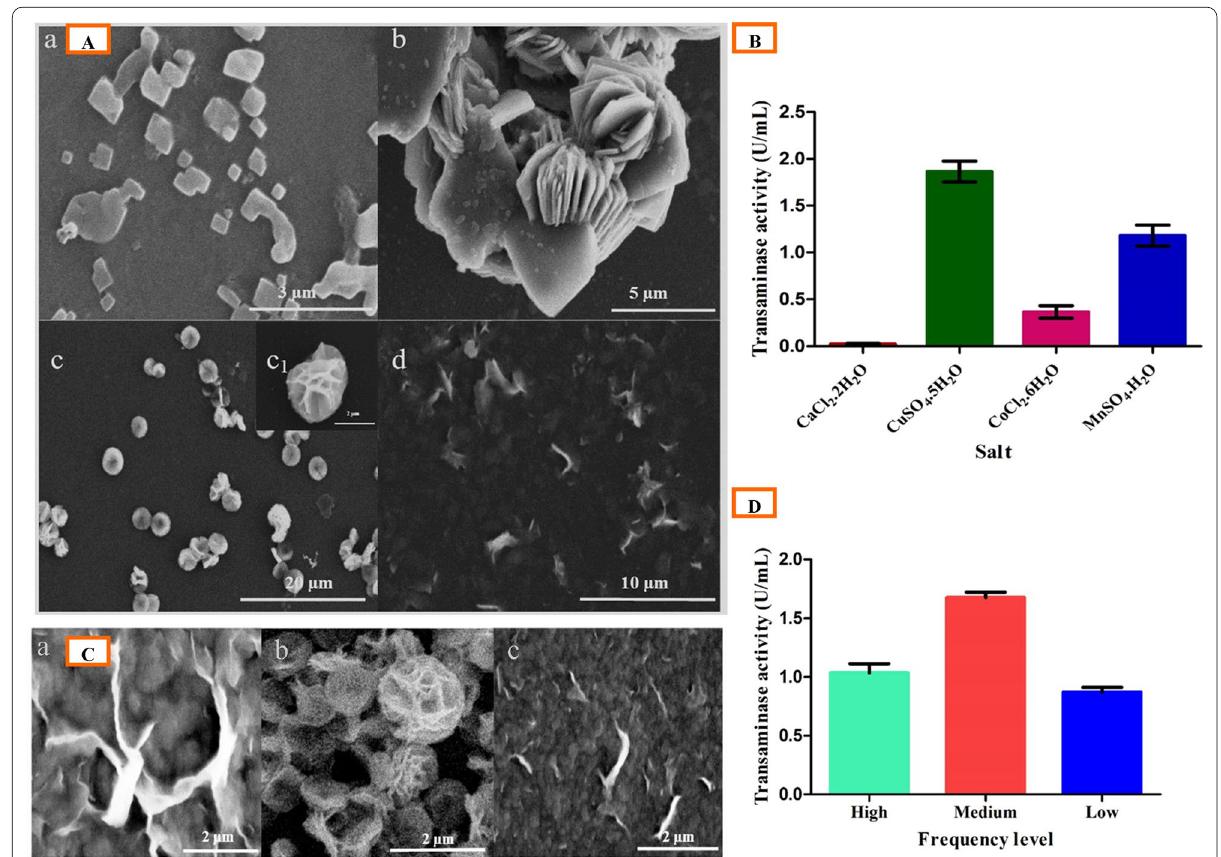
Fig. 2 A SEM images of sonication-mediated transaminase nanoflower synthesis with different metal salt in 120 mM concentration, a CaCl 2 .2H 2 O, b CoCl 2 .6H 2 O, c CuSO 4 .5H 2 O, d MnSO 4 .H 2 O, and c 1 magnified image of c. B TA activity of hybrid nanoflower synthesis with different metal salts. C SEM images of hybrid nanoflowers synthesized at different power level, a low, b medium, and c high. D TA activity of nanoflower synthesis at different power